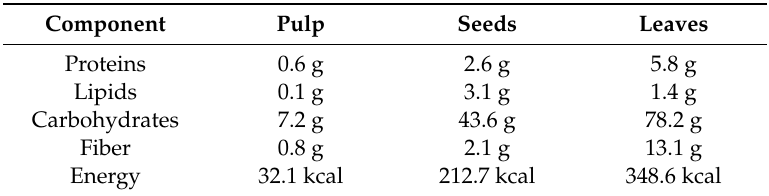
Table 1. Nutritional value of the macronutrients and fibers of Carica papaya L. (papaya) per 100 g of pulp of ripe fruit, seeds and leaves [5,18].